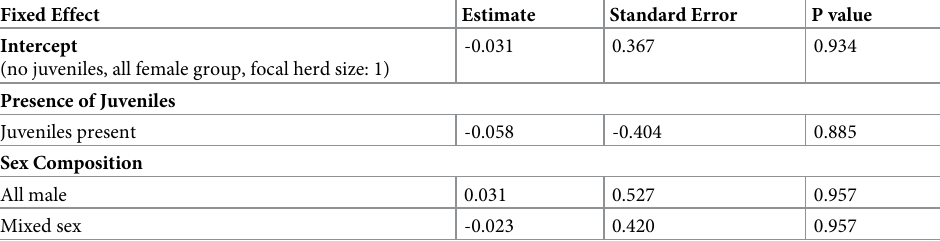
Table 9. Coefficients and P values for the final analysis on social factors influencing the formation of mixed-spe- cies groups (N = 126).